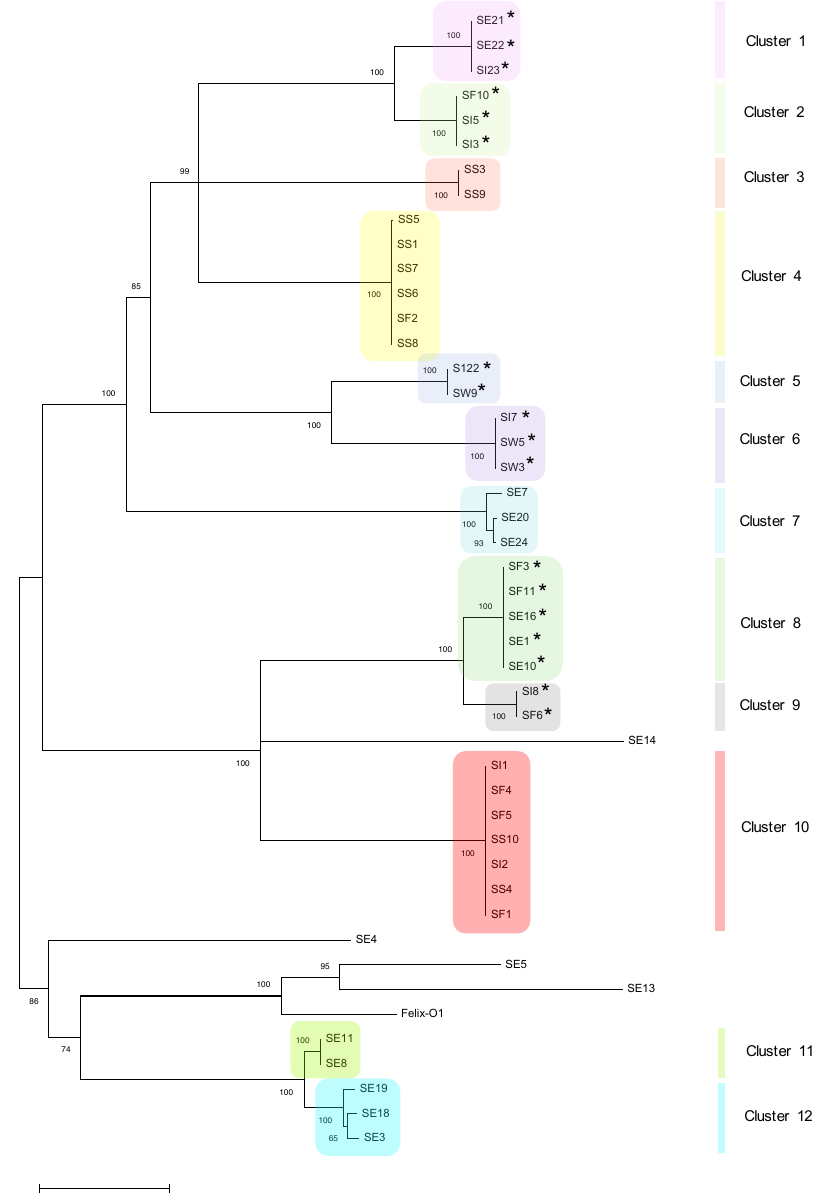
Figure 2. Dendrogram of whole genome nucleotide alignment. Tree was constructed using the ClustalW alignment and the Maximum-Likelihood method in MEGA X with 1000 bootstrap replicates. Bootstrap percentages are shown next to each node. Scale represents the number of nucleotide substitutions per site. Putatively temperate phages are indicated with an asterisk